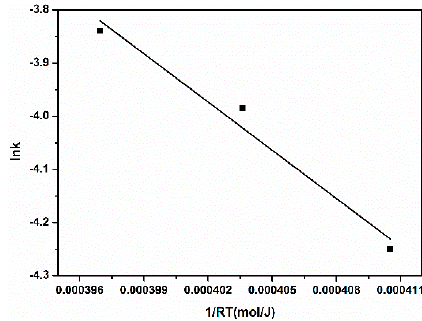
Figure 8. Arrhenius fitting plot of the catalysis degradation. Table 1. First-order dynamic fitting parameters.